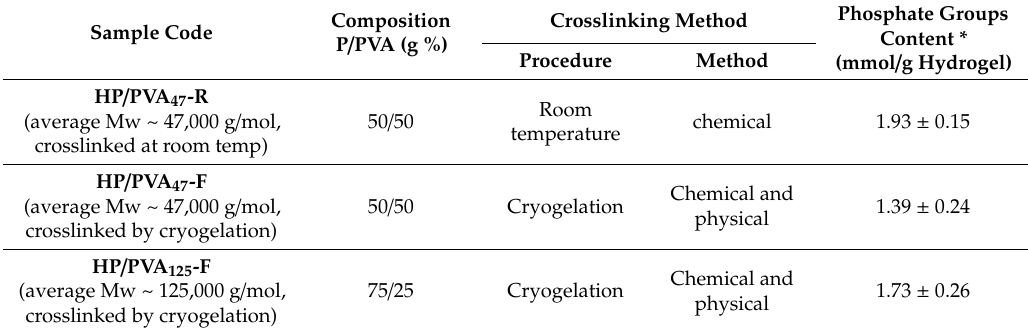
Table 1. Preparation conditions and phosphate groups content of HP / poly(vinyl alcohol) (PVA) composite